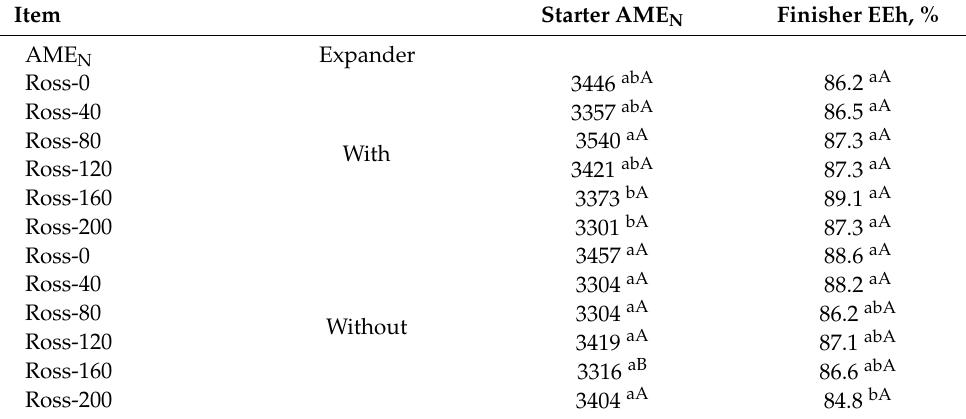
Table 7. Breakdown of significant interactions as presented in Table 6.